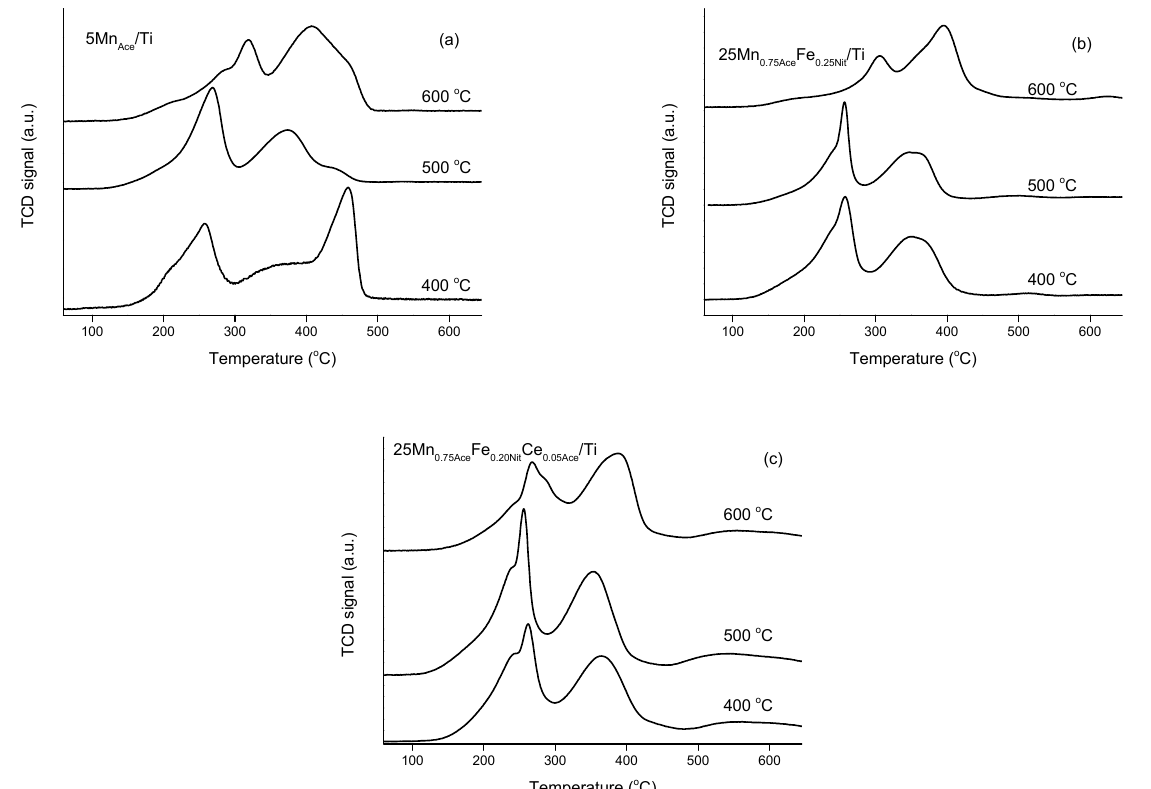
Figure 9. H 2 -TPR (temperature-programmed reduction with hydrogen) profiles of catalysts calcined at various temperatures: ( a ) 5MnAce/Ti; ( b ) 25Mn 0.75Ace Fe 0.25Nit /Ti; and ( c ) 25Mn 0.75Ace Fe 0.20Nit Ce 0.05Ace /Ti.